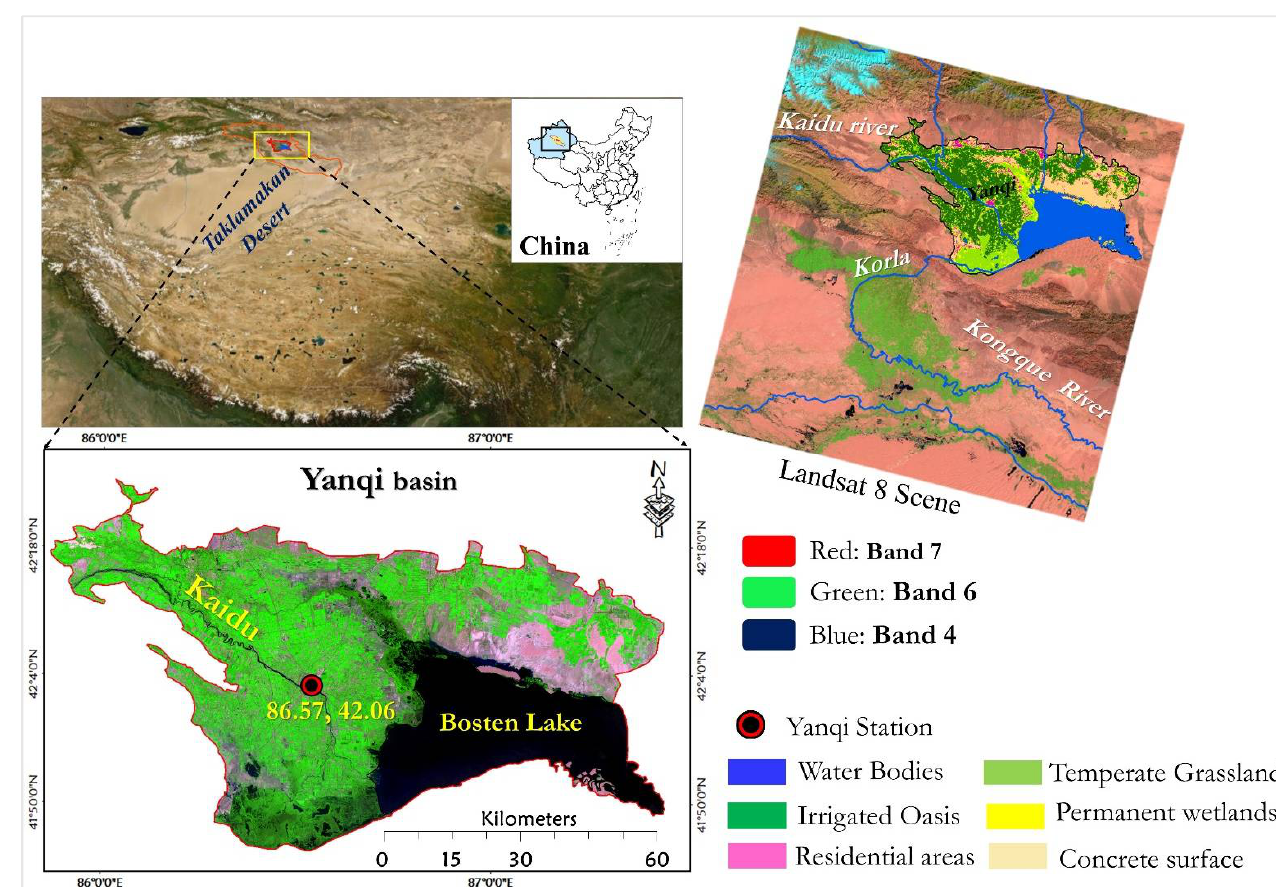
Figure 1. Location of Yanqi ecosystem in the large Bosten Lake Basin, China. The map is from Chinese Standard Map (http://bzdt.ch.mnr.gov.cn/, GS (2019)1652)